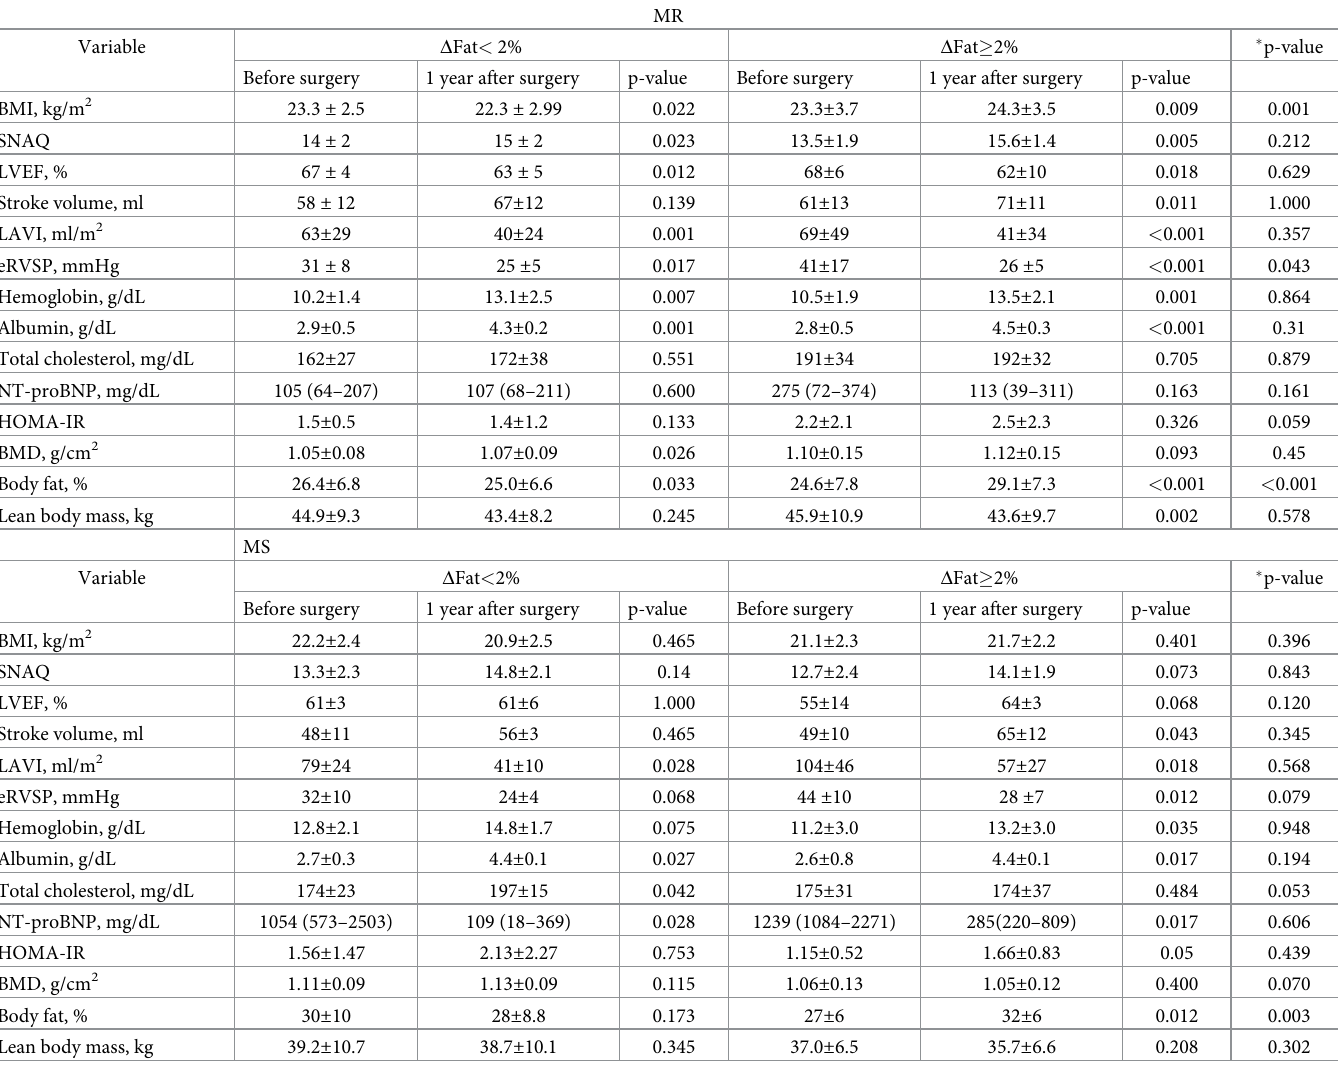
Table 3. Comparisons of changes in anthropometric, echocardiographic, and laboratory data before and after mitral valvular surgery according to the primary valve lesion with respect to the change in body fat percentage.